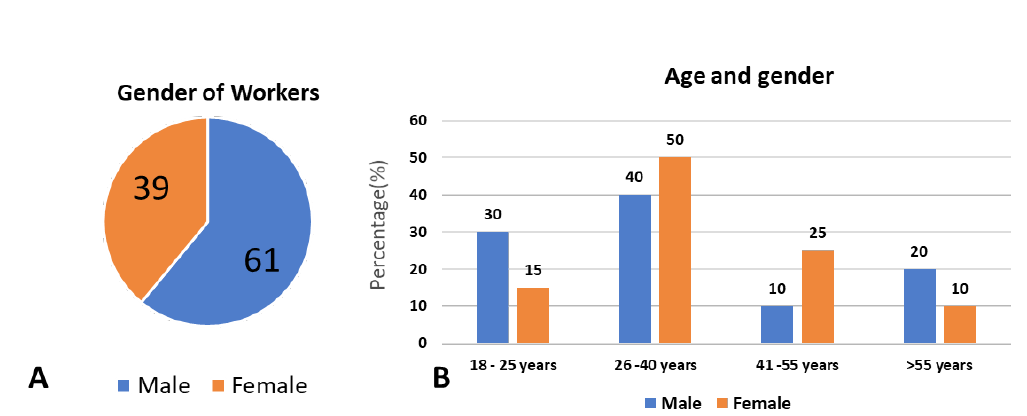
Figure 12. Gender and age distribution of workers in asparagus and avocado farms in 2017. (A) Percentage of workers by gender. (B) Gender and age of workers on asparagus and avocado farms.